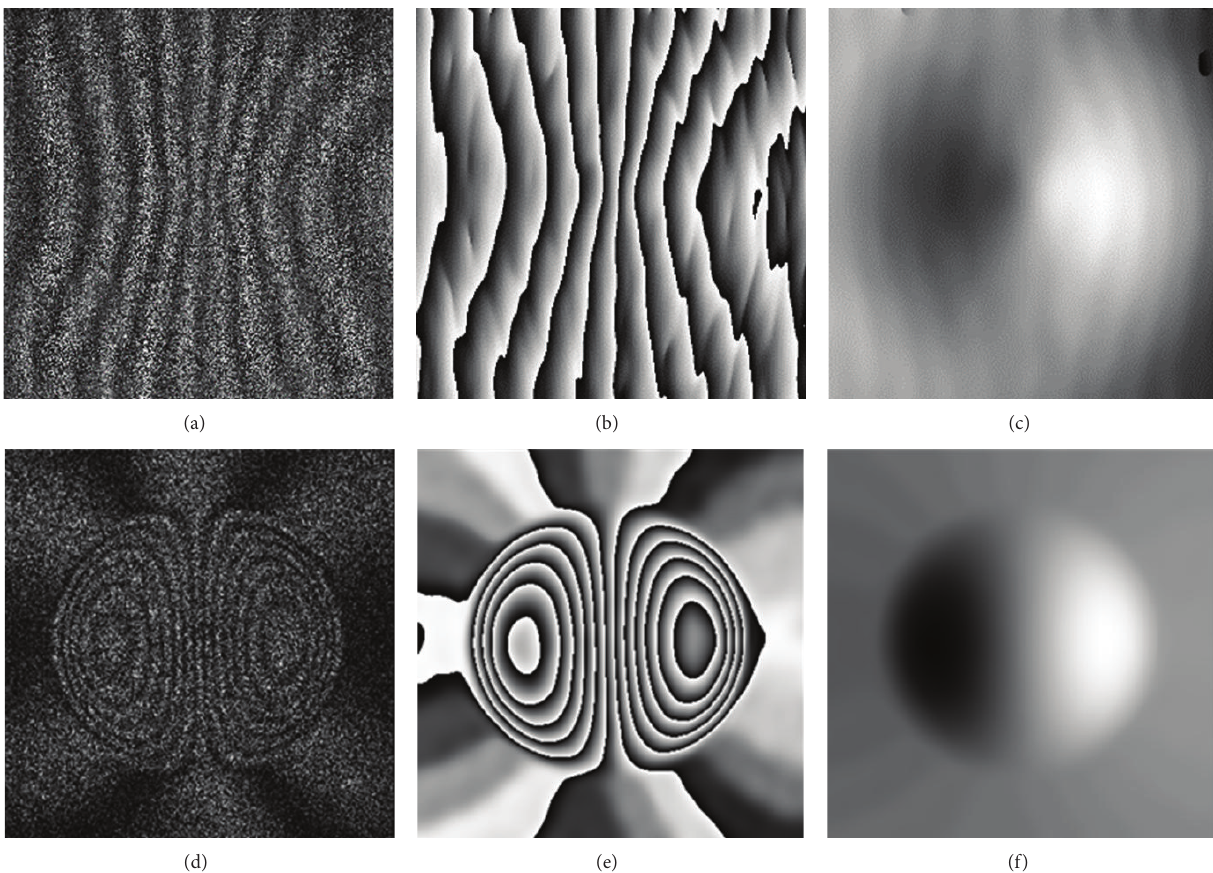
Figure 4: (a) Typical shearography fringe pattern, (b) wrapped phase map, and (c) phase after unwrapping and removal of the spatial carrier; (d) shearography fringe pattern, (e) wrapped phase map, and (f) phase after unwrapping when the temporal carrier is applied (reprint from